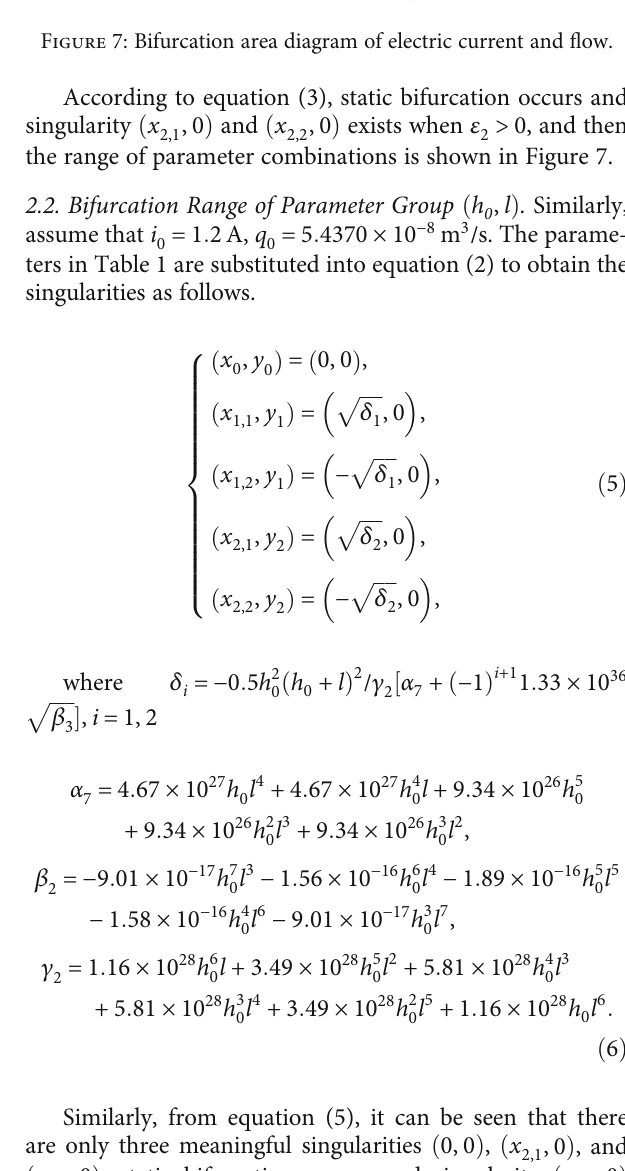
Figure 6: Relationships among x